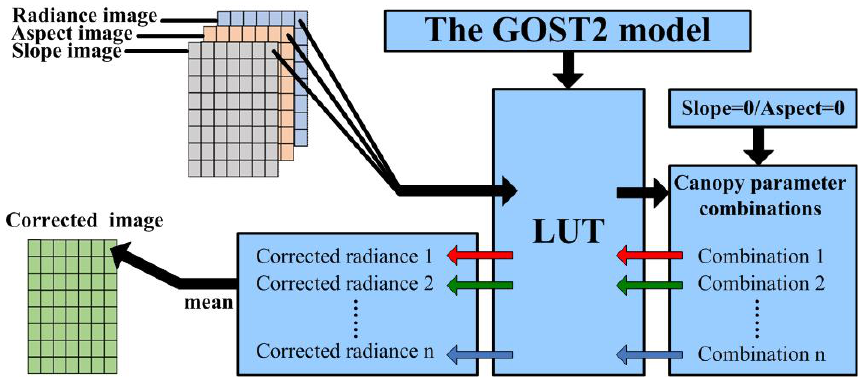
Figure 1. The flowchart of the MFM-GOST2 method.